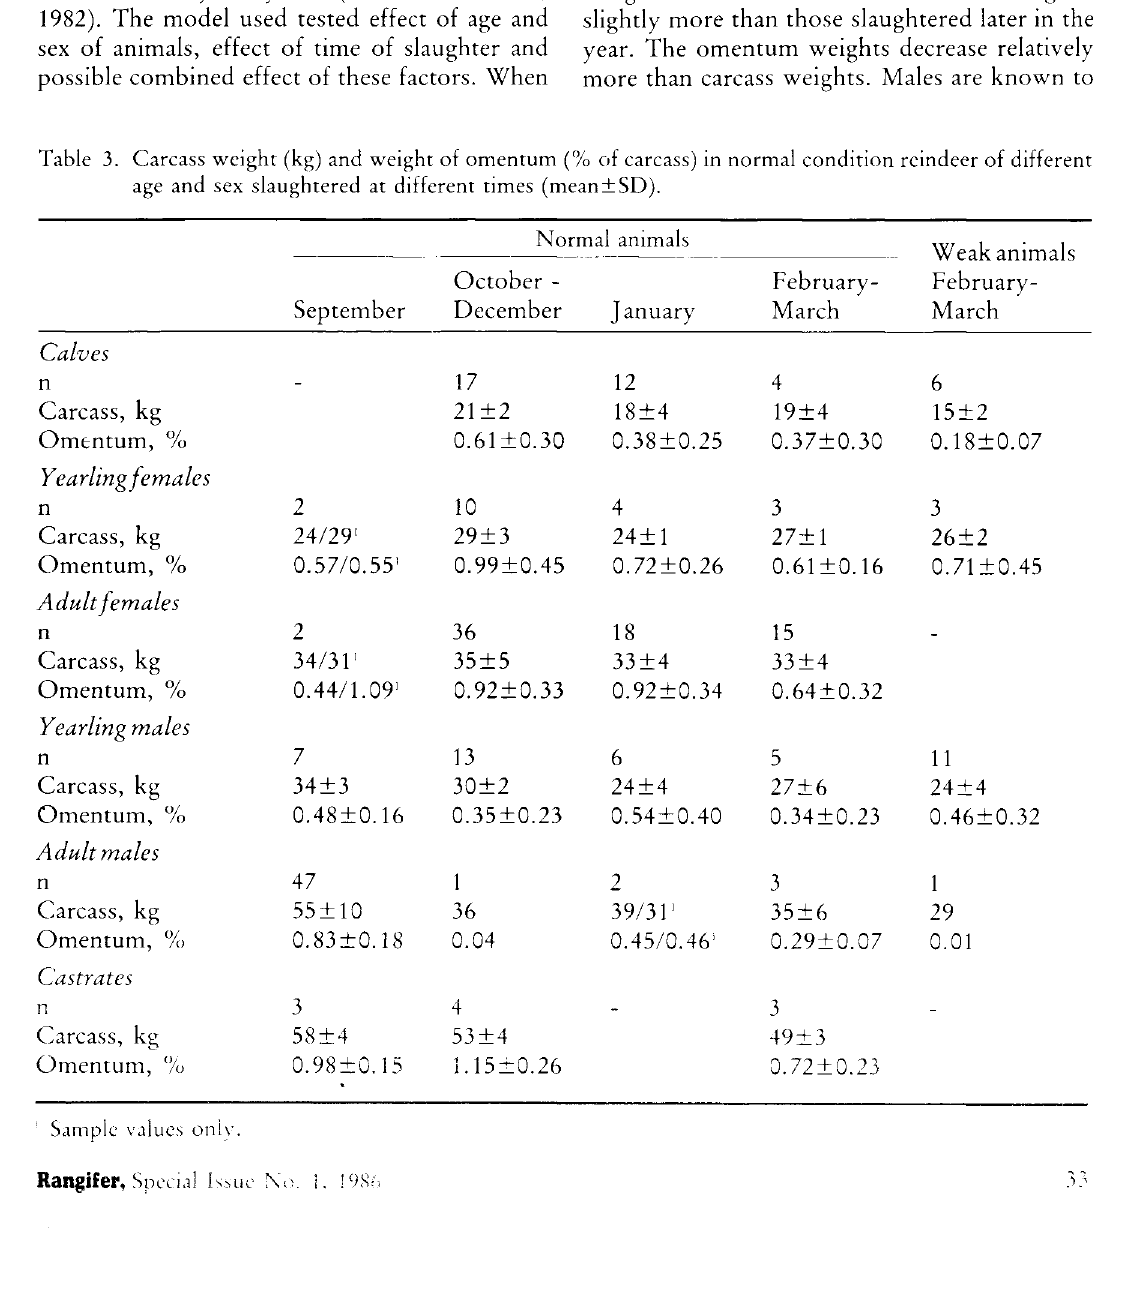
Table 3. Carcass weight (kg) and weight of omentum (% of carcass) in normal condition reindeer of different age and sex slaughtered at different times